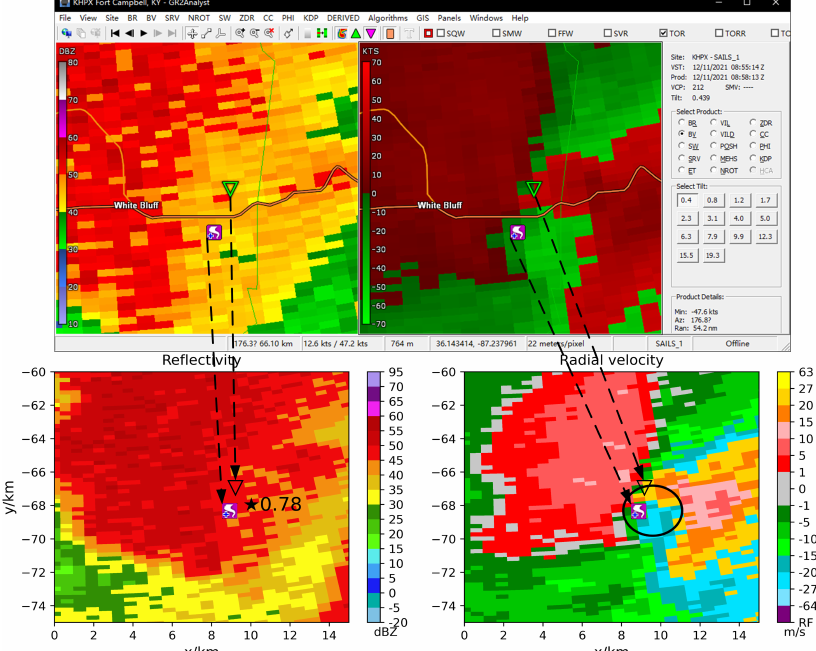
Figure 12. TDA-RF detection results on NEXRAD radar data. KHPX radar 2021-12-11 08:58 (UTC), the tornado was EF2. (The inverted triangle is the warning result of GR2Analyst, the asterisk and circle are the warning result of